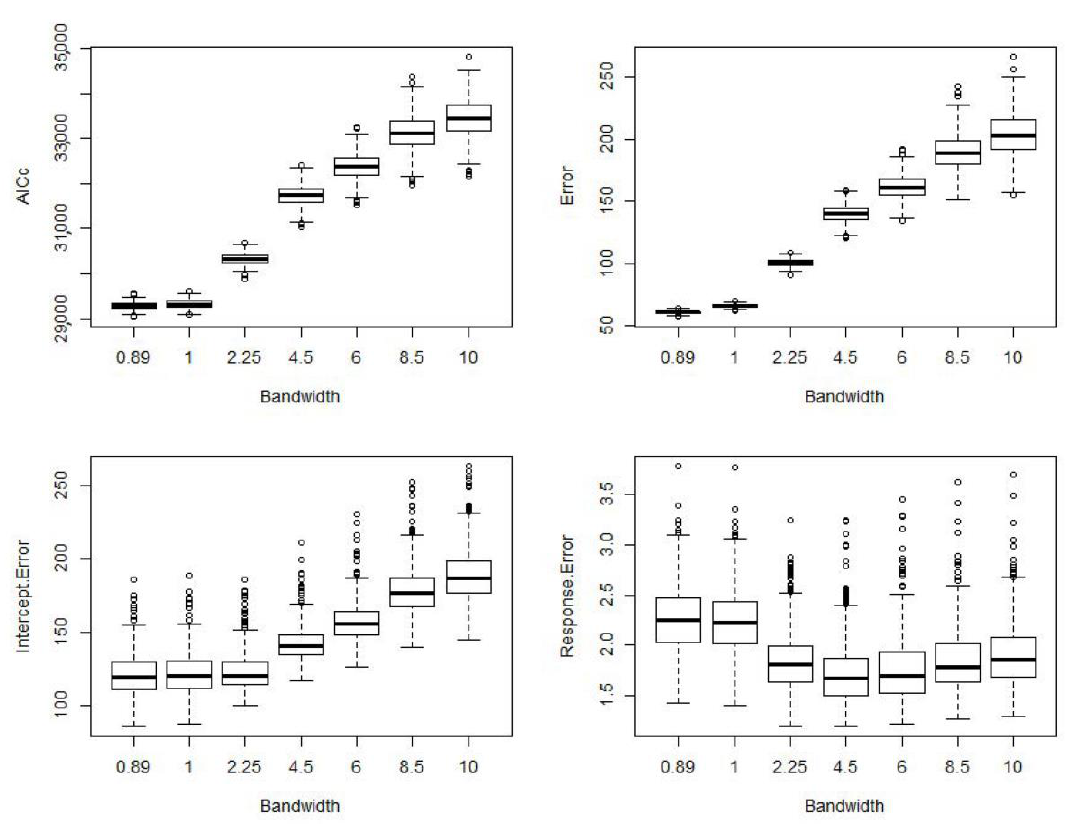
Figure 9. Distribution of AICc and error components calculated for 500 simulations of locally varying linear response of yield to fertiliser application with varying bandwidths.